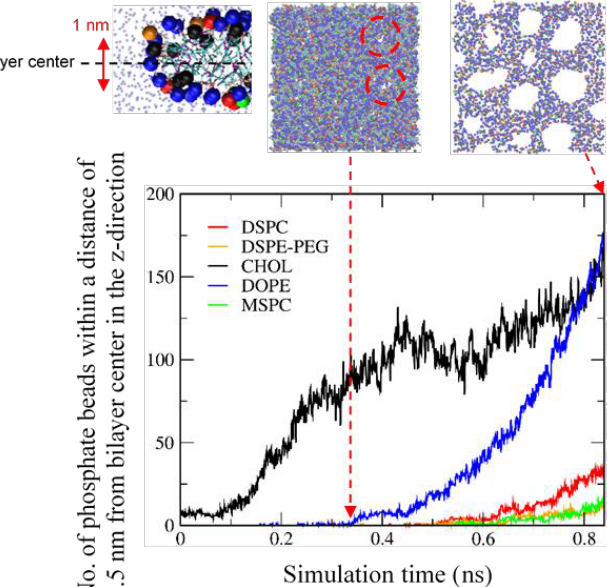
Figure 14. Number of beads of lipid phosphates or cholesterol hydroxyl-groups within a distance of 0.5 nm from bilayer center in the z direction, as a function of simulation time.